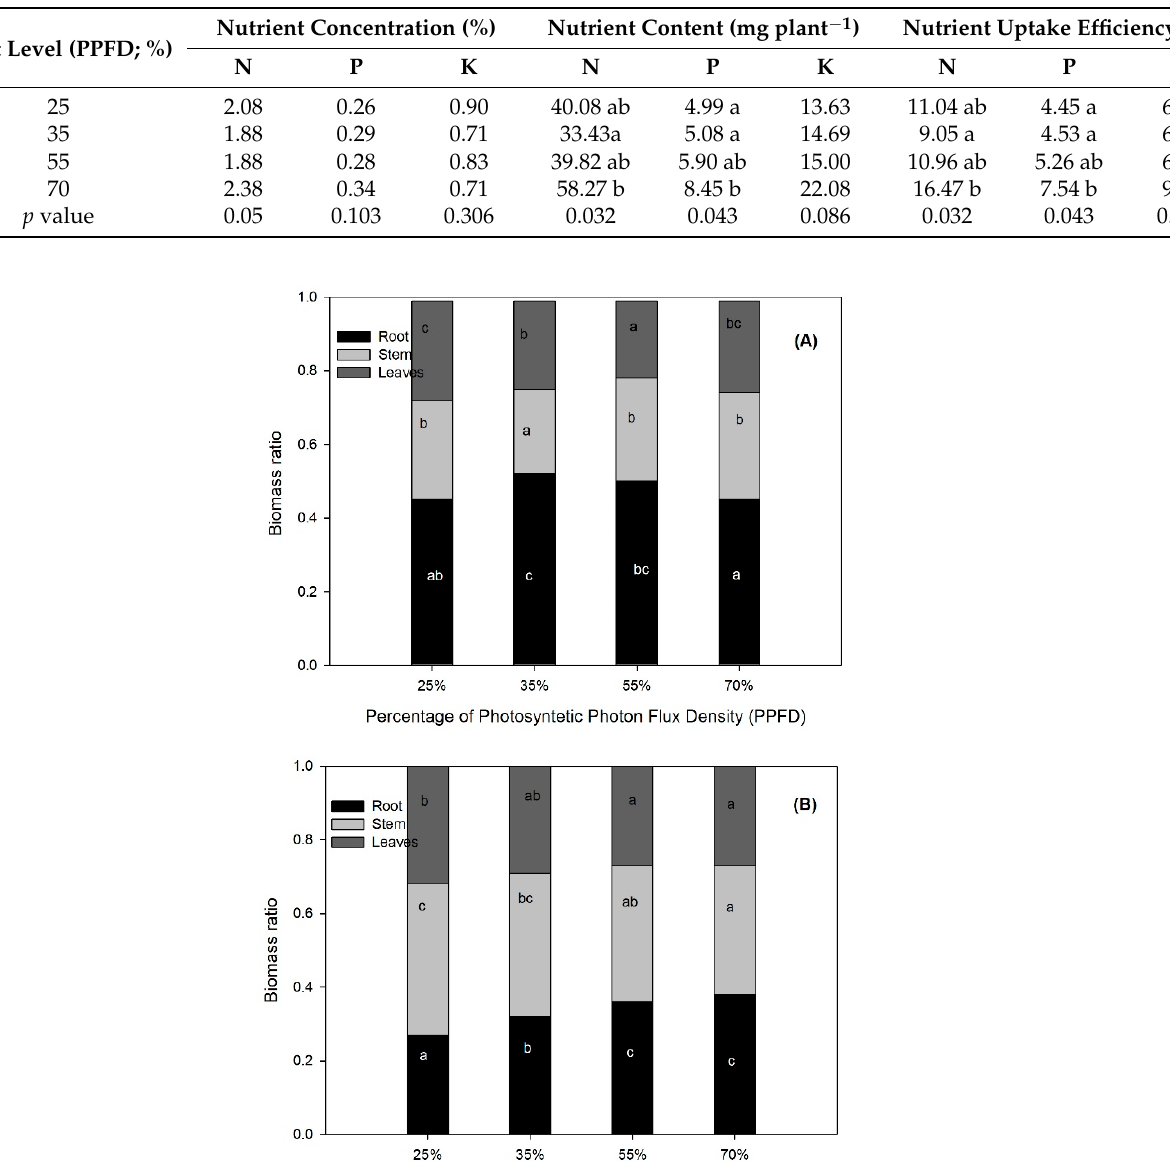
Figure 1. Biomass allocation patterns of ( A ) Crescentia alata and ( B ) Enterolobium cyclocarpum plants exposed to varying photosynthetic photon flux density (PPFD) levels ( n = 12). Segments in the bars with a letter in common among bars are not significantly different ( p > 0.05) according to Fisher’s LSD test ( α = 0.05).